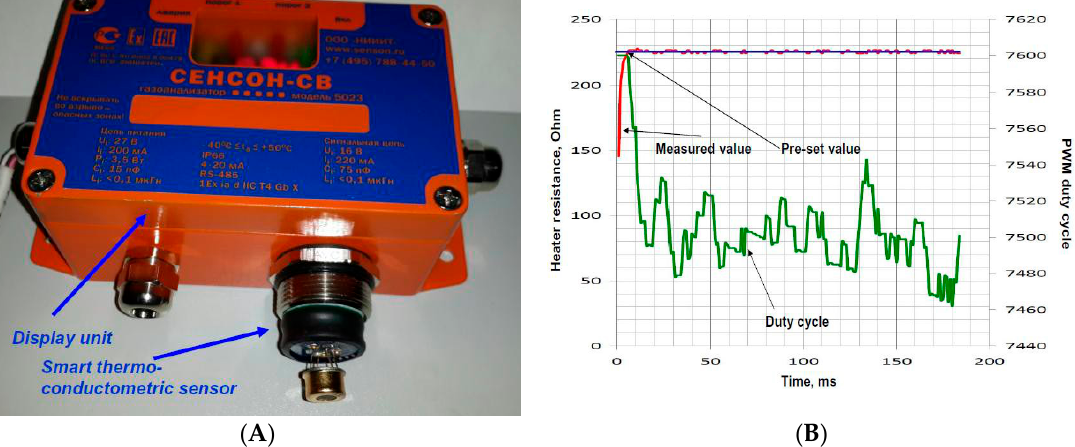
Figure 3. ( A ) Smart sensor unit used for the stabilization of temperature of microheater, measurement of power supplied to the microheater at this stabilized temperature, and for the connection with read-out instrument. ( B ) Heating process of ceramic MEMS gas sensor. Pre-set resistance corresponds to working temperature of 350 °C. 100% duty cycle of PWM corresponds to τ 8000 value at the right axis. 90 of the heating process is of ~8